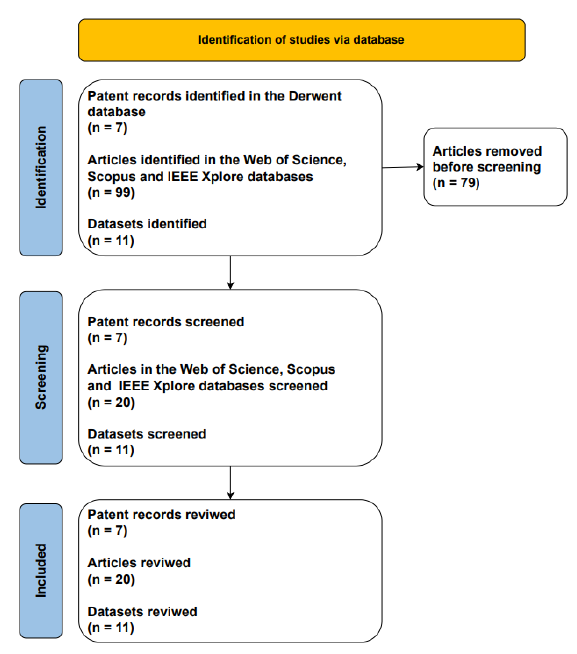
Figure 2. Systematic review flow diagram, adapted from PRISMA